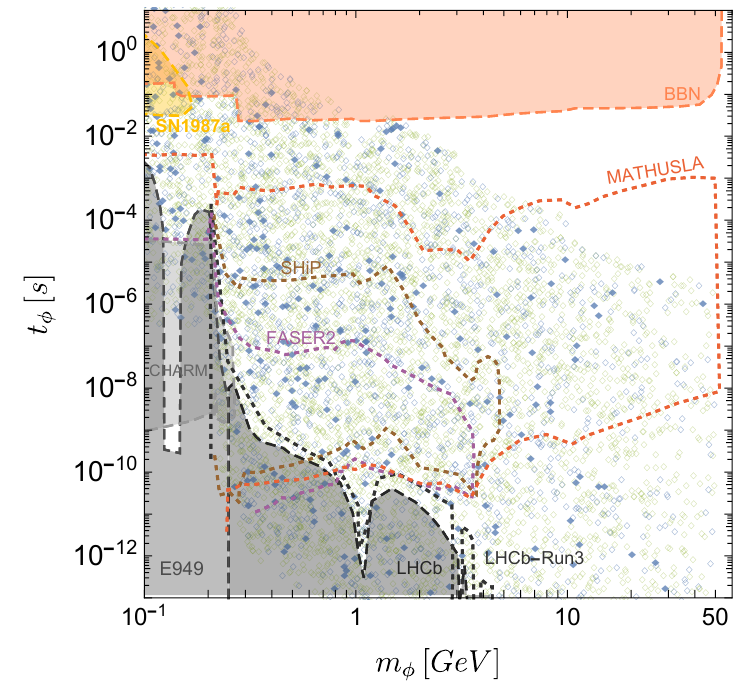
Figure 4 . The results of the scan showing points with Ω h 2 = 0 . 12 ± 0 . 012 projected onto the ( m φ , t φ ) plane. The blue (green) colors indicate points with the dominant semi-annihilation σv χχ → χφ > σv χχ → φφ (pair-annihilation σv χχ → χφ < σv χχ → φφ ) process. The superimposed constraints on the mediator φ are shown as shaded regions: recasted [41] results from CHARM [42], E949 [43] and LHCb [44, 45] (gray); the limits from BBN [46] (orange) and SN1987a [47] (yellow). Also we show the prospects for the future experiments with dashed lines: FASER [48] (violet), SHiP [49] (blue) and MATHUSLA [50] (red) and LHCb-Run3 (black) adopted from